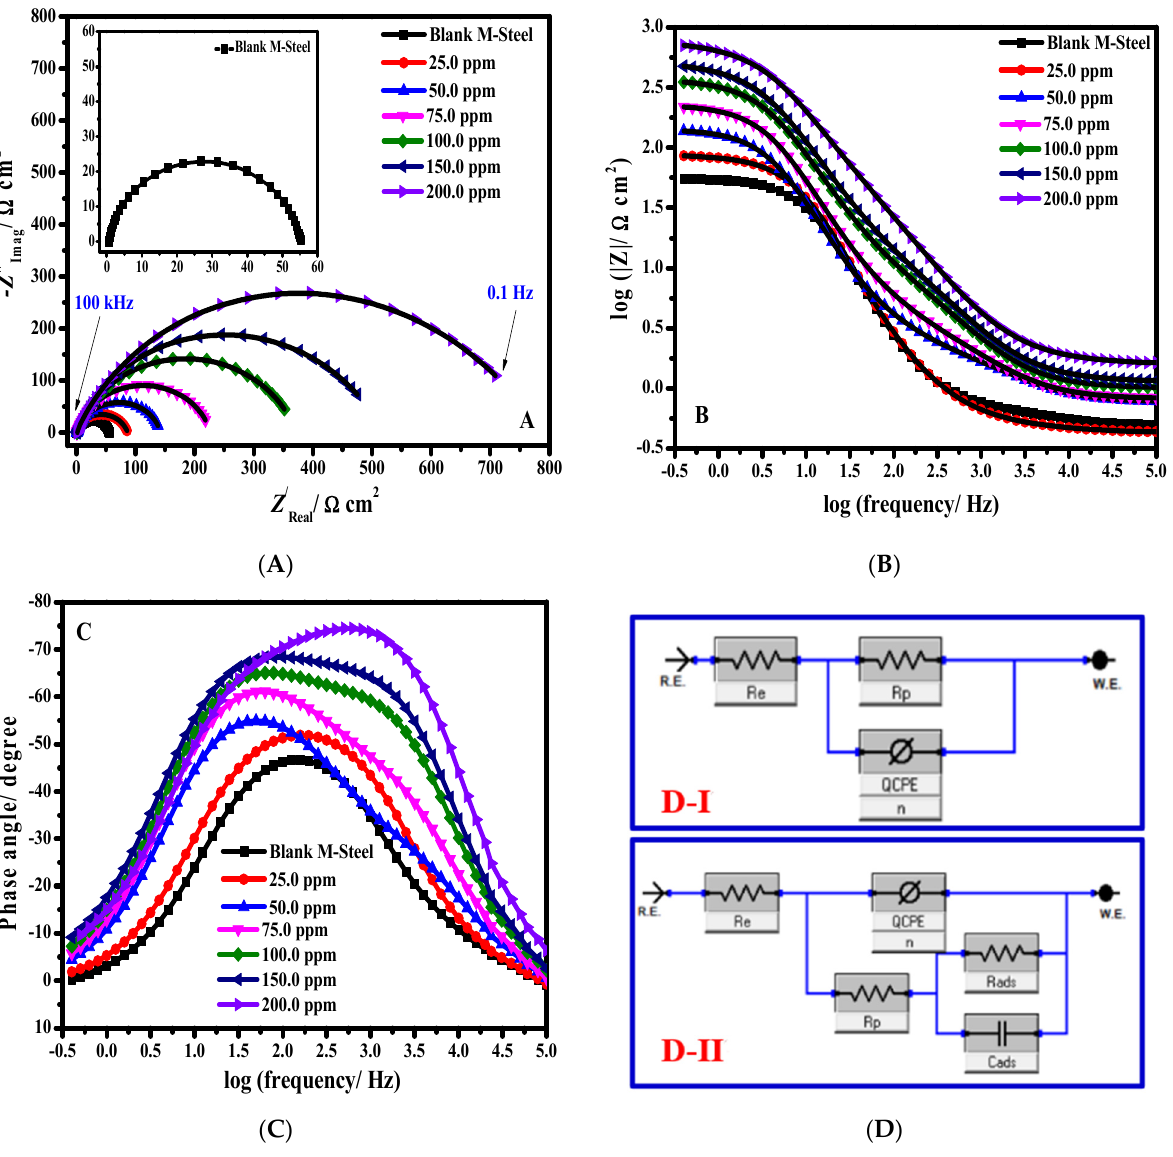
Figure 7. MS-alloy Nyquist plots ( A ) and Bode diagrams ( B , C ) in blank HCl containing brine and with six concentrations (25 mg/L, 50 mg/L, 75 mg/L, 100 mg/L, 150 mg/L, and 200 mg/L) ZnNiO@PANE, and at 298 K. Equivalent electrical circuit ( D ) in the blank (I) and inhibited systems (II).